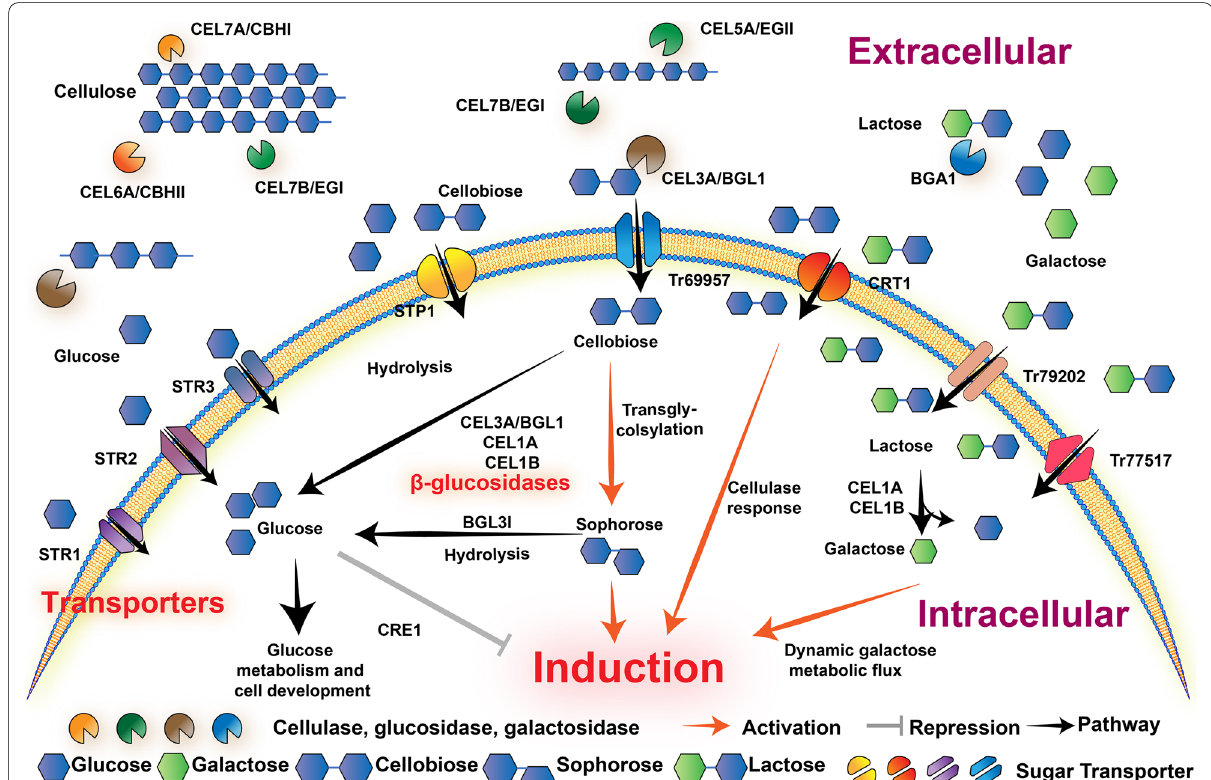
Fig. 1 Overview of cellulase induction in T. reesei . This figure shows the process of cellulase induction on cellulose and lactose. Initially, the cellulase CEL7A/6A, CEL7B/5A and β‑glucosidase CEL3A are involved in the degradation of cellulose, and BGA is essential for the cleavage of lactose. Next, the released mono‑ and disaccharides could be transported intracellularly through sugar transporters and participate in different metabolic pathways. Among that, different β‑glucosidases are critical for efficient cellulase production either on cellulose or lactose, through mediating the accumulation and formation of inducer. The key components and factors are depicted in corresponding